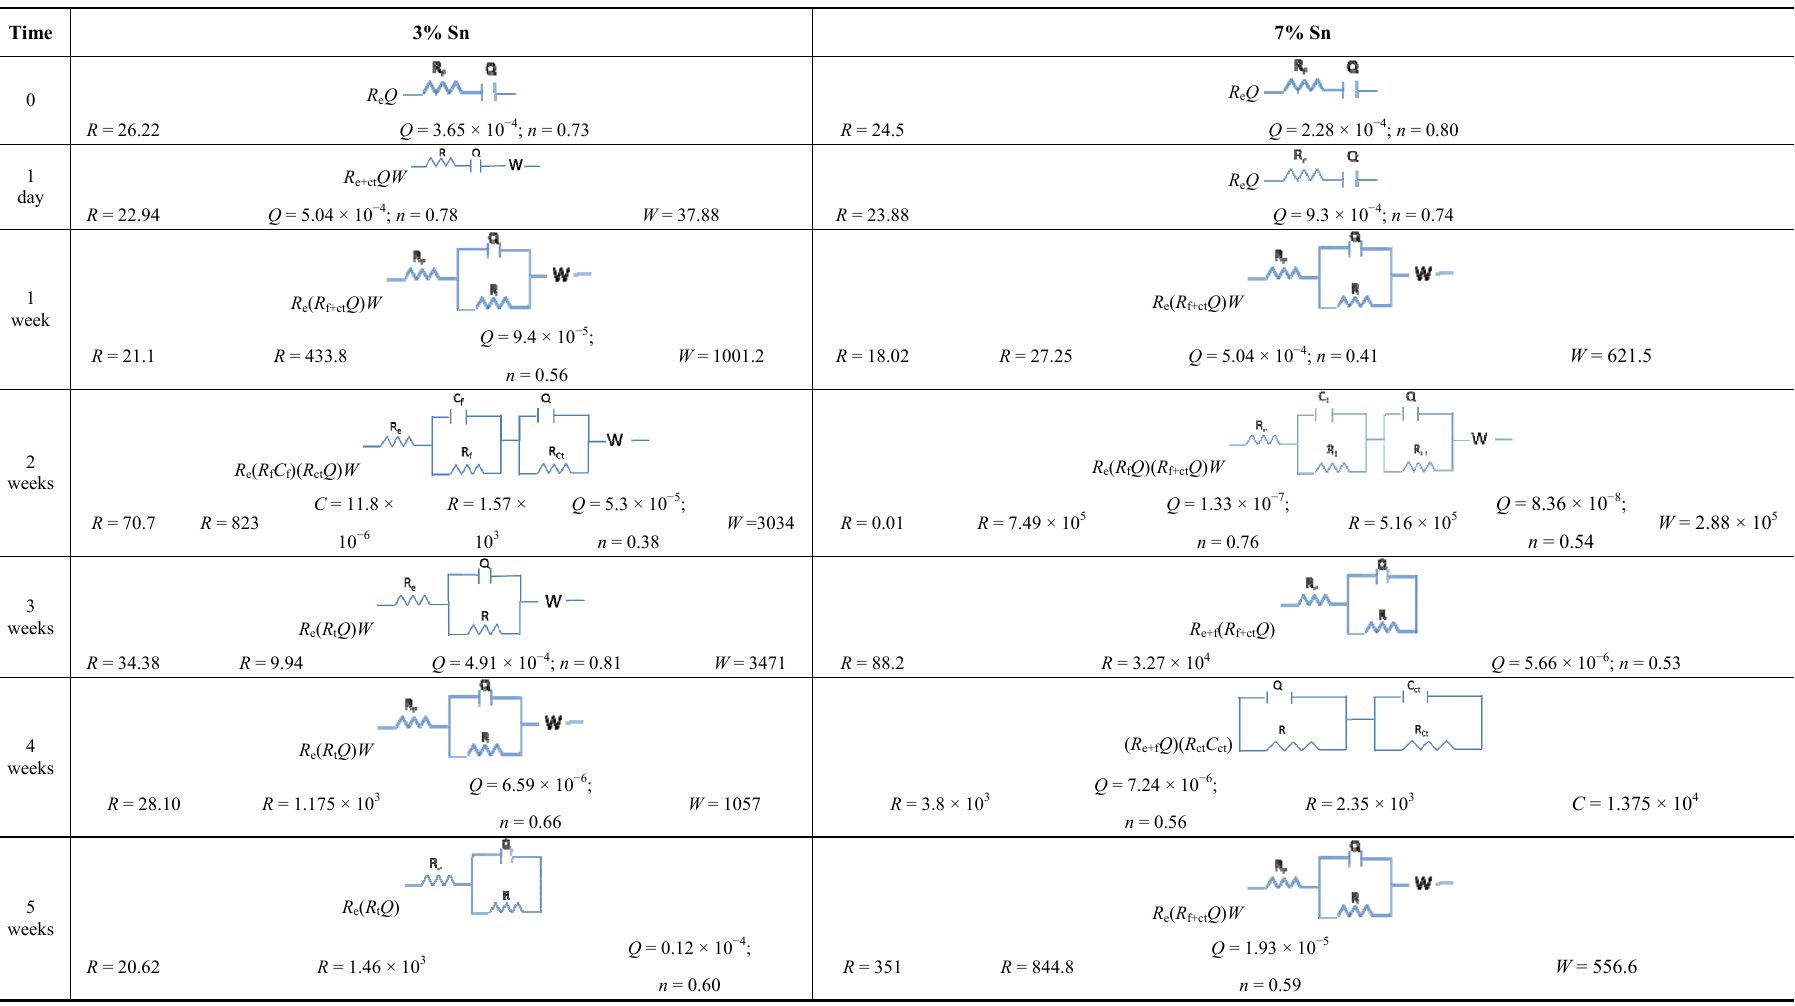
Table 1. Equivalent circuits for 3% Sn bronze and 7% Sn bronze immersed in the artificial acid rain solution. The film resistance ( R capacitance ( C ); the resistance ( R ) and capacitance ( C ) of charge transfer; the resistance of the electrolyte ( R f ct ct constant phase element ( Q ); and its index n (present only with Q